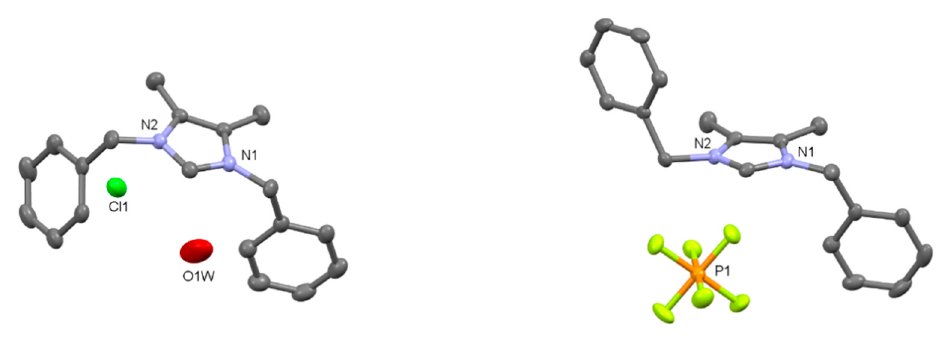
Figure 4. Structures of Lepidiline A (left) and its PF 6 derivative (right) as determined by single crystal diffraction. Atoms are shown as 50% probability ellipsoids. H atoms, disorder in the solvent, and anion of 3·HCl and the second independent cation-anion pair of 3·HPF 6 have been omitted for clarity.